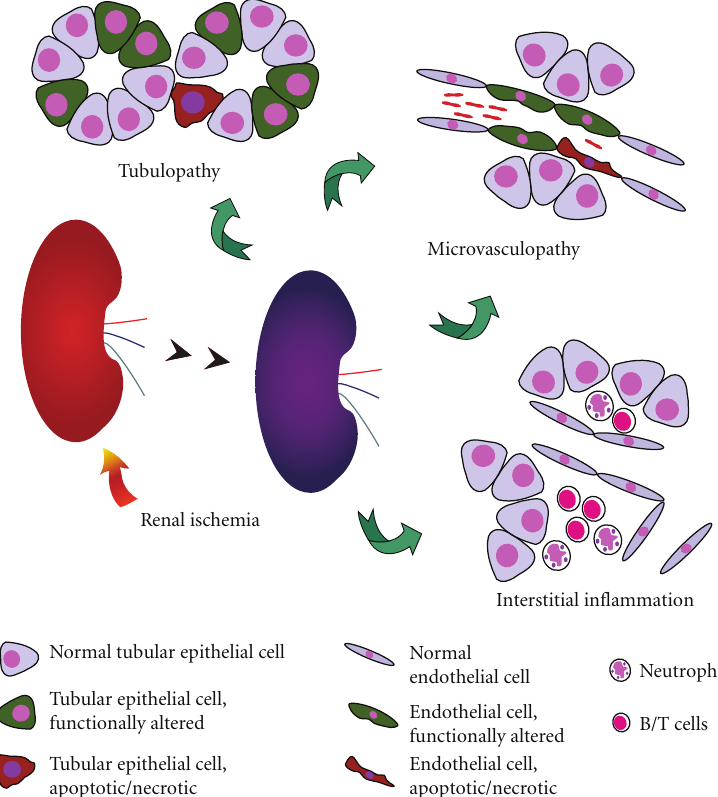
Figure 1: Acute ischemic renal failure is characterized by tubular epithelial cell dysfunction and damage. Postischemic restoration of kidney function and structure critically depends on both interstitial inflammation and peritubular microvasculopathy. The latter causes ongoing renal hypoperfusion even if ischemia has been